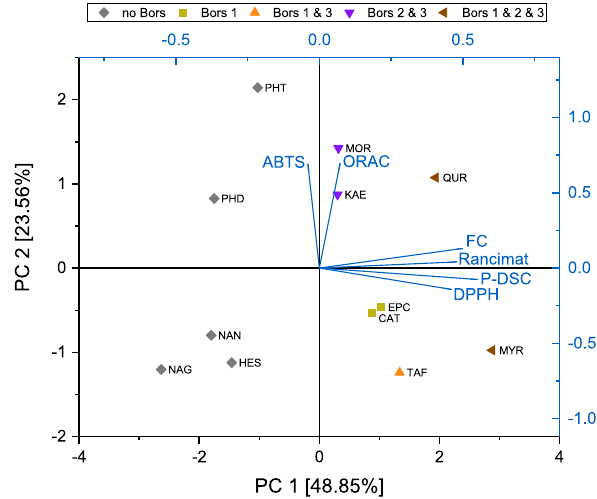
Figure 4. PC analysis of results of flavonoids from Rancimat and the P-DSC, ABTS, DPPH, FC, and ORAC assays presented in dependence of Bors